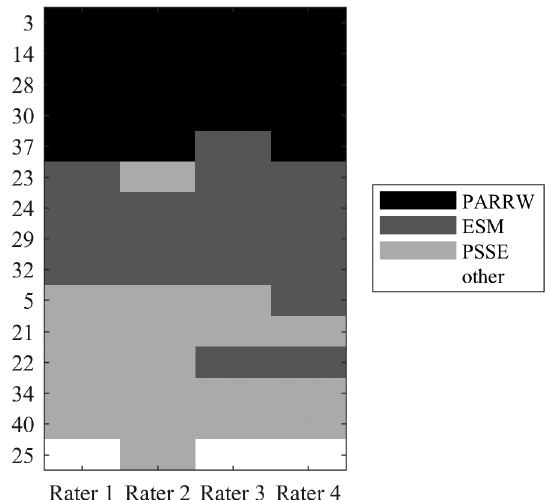
FIG. 1. Coding of the 15 statements included in the analysis. X axis: rater, y axis: question